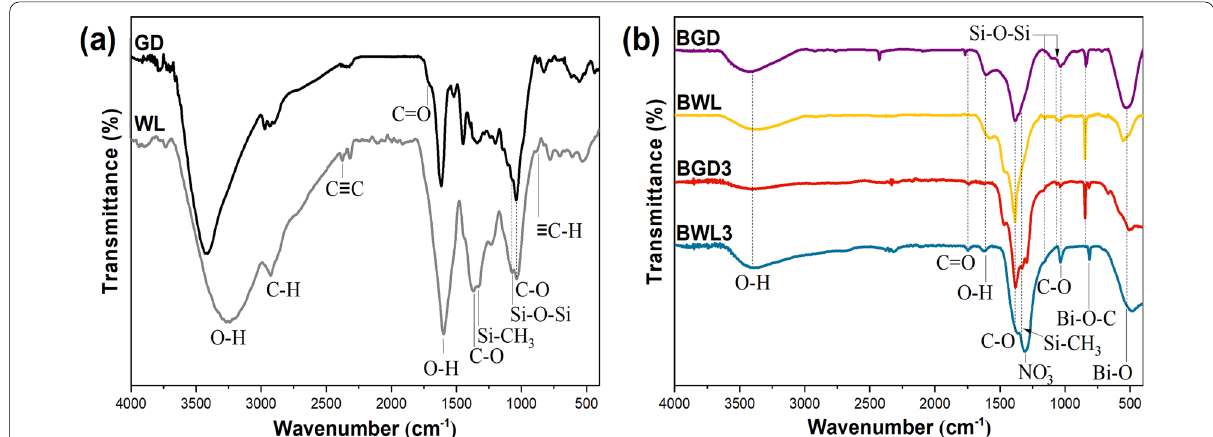
Fig. 1 FT‑IR spectra of aqueous extracts of J. regia shell and green synthesized